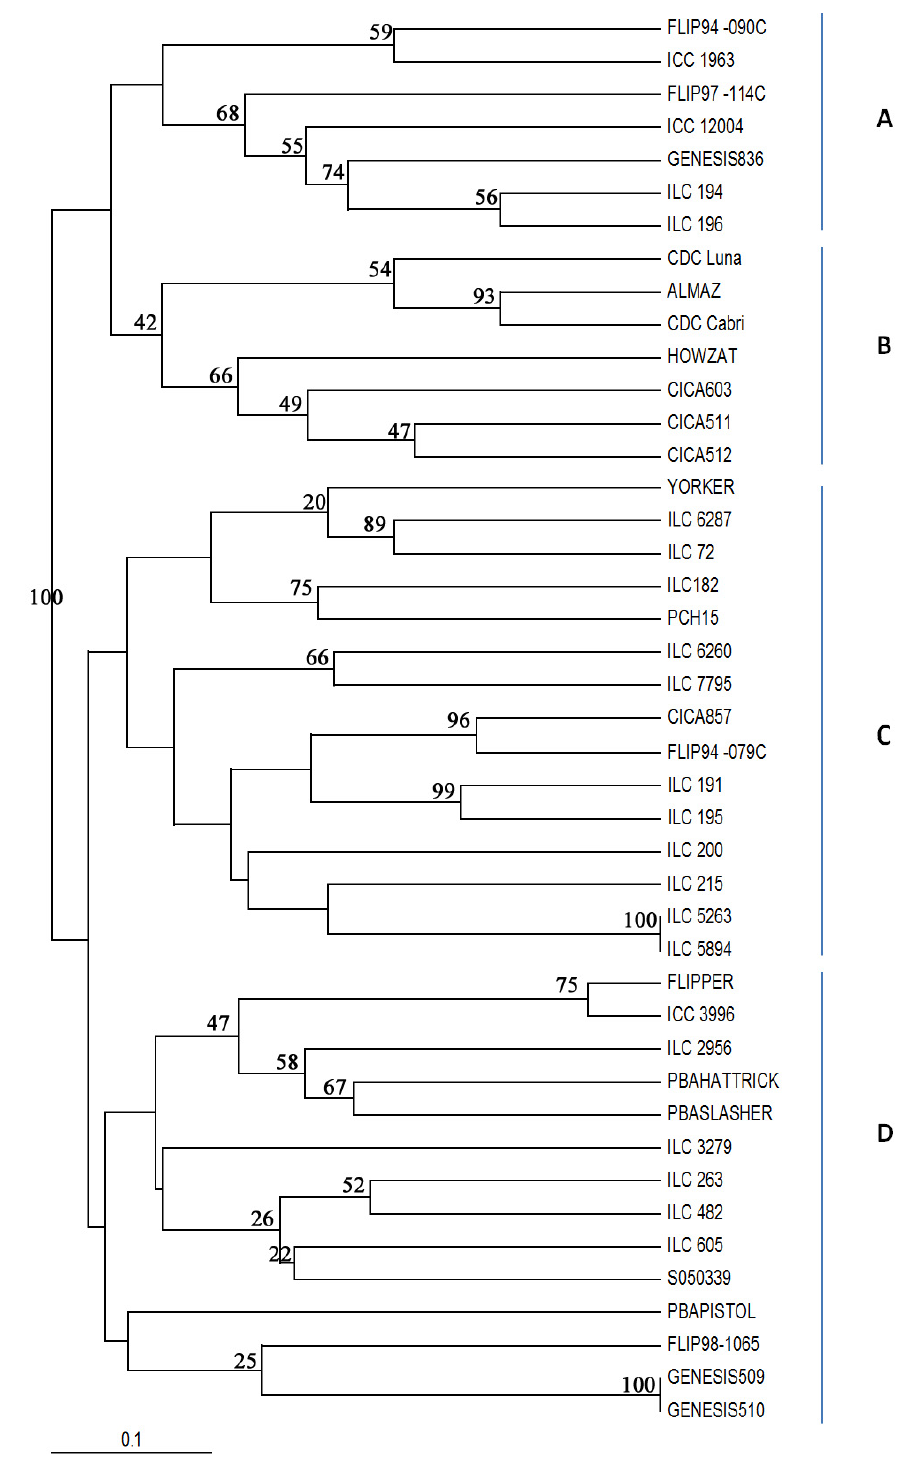
Figure 1. Dendrogram showing different groups of chickpea genotypes, resistant and susceptible to Ascochyta blight. The groups are denoted on the right side as A or B, C and D. Bootstrap values of above 20% are indicated at the